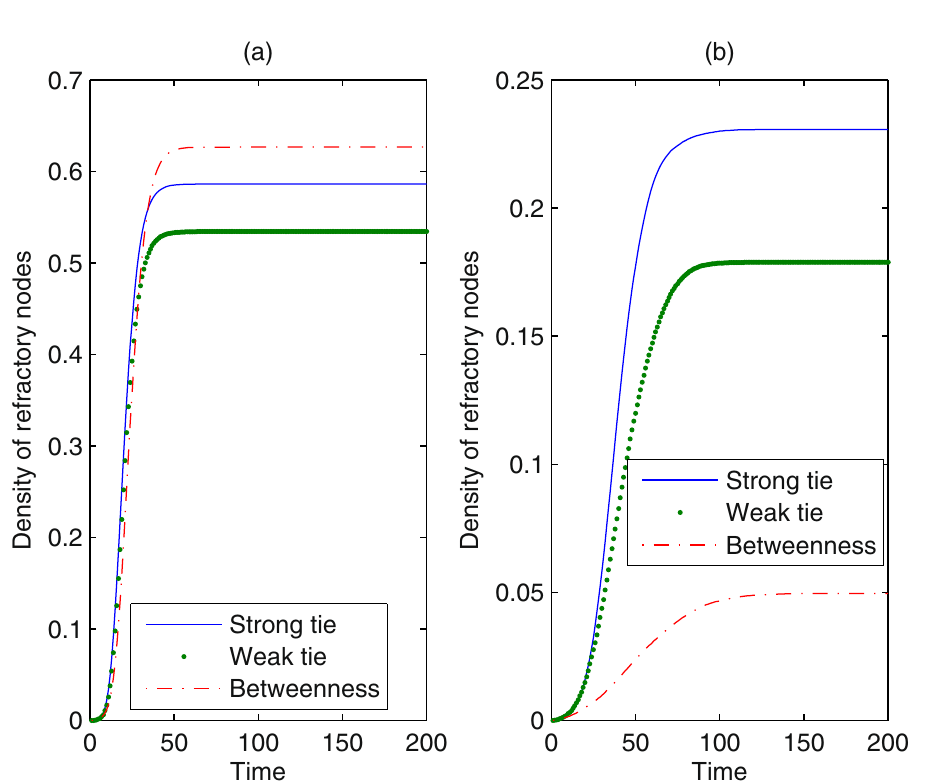
Figure 5. Density of refractory nodes with the method of blocking edges. The underlying network is a scale- free network, λ = 0.2, and δ = 0.2. In the left plot, the proportion of edges that are blocked is γ = 0.1. In the right plot, γ is set at 0.4. Every plot is an average of 100 different